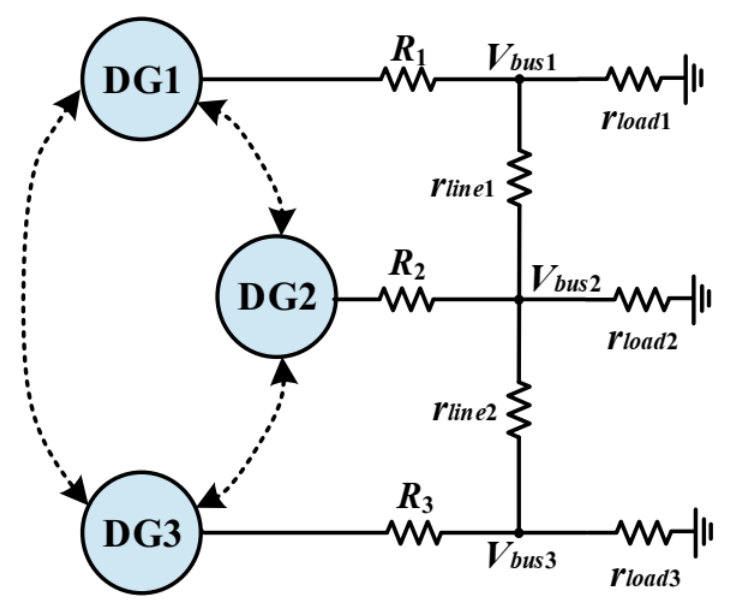
Figure 6. Structure of the test DC